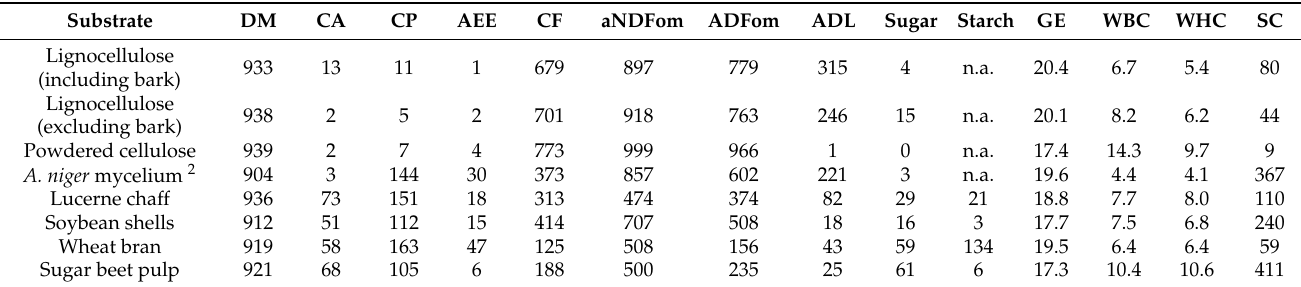
Table 2. Chemical composition and physicochemical properties of test substrates 1